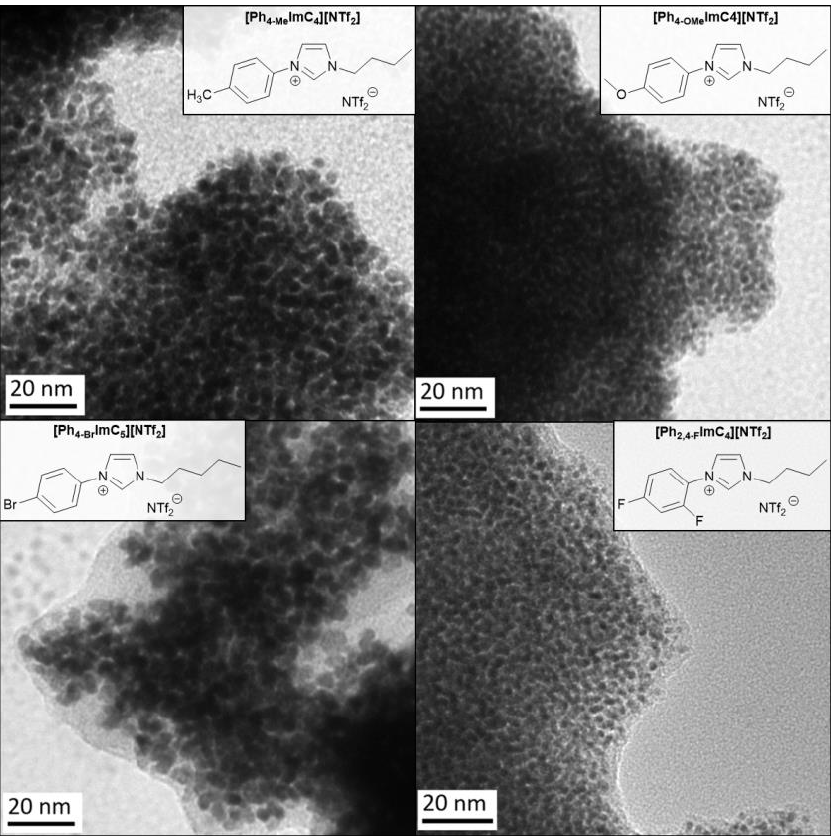
Figure 3. TEM images of (TAAIL)Pt-NPs obtained in the (non-C2-substituted) TAAILs [Ph 4-Me ImC 4 ][NTf 2 ] (MP4), [Ph 4-OMe ImC 4 ][NTf 2 ] (MOP4), [Ph 4-Br ImC 5 ][NTf 2 ] (BP5) and [Ph 2,4-F ImC 4 ][NTf 2 ] (DFP4).